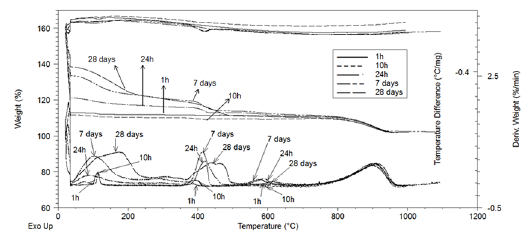
Figure 7. TG/DTG and DTA curves of sample with 20% NaCl in its hydration S hydration. 3